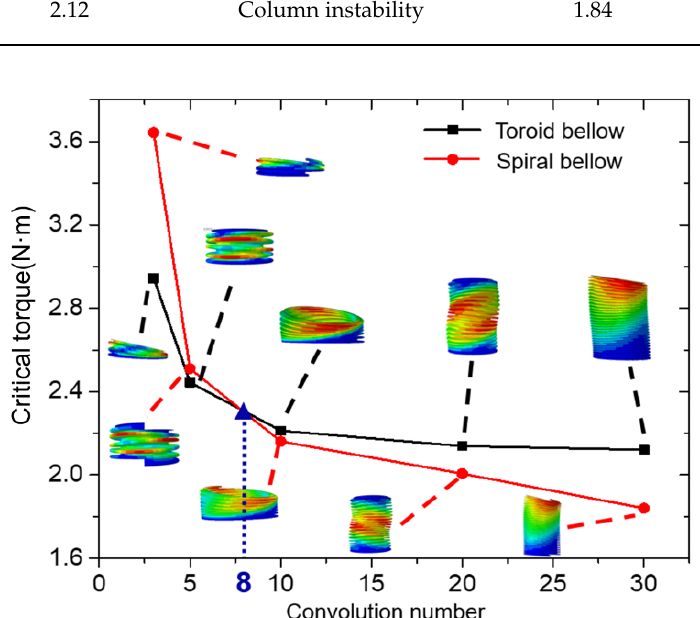
Figure 7. Curve of critical torque versus the number of convolutions.